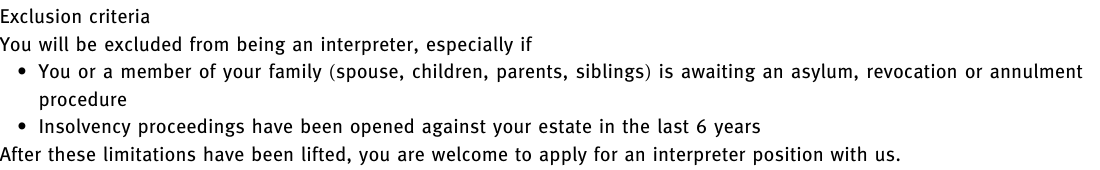
Exclusion criteria